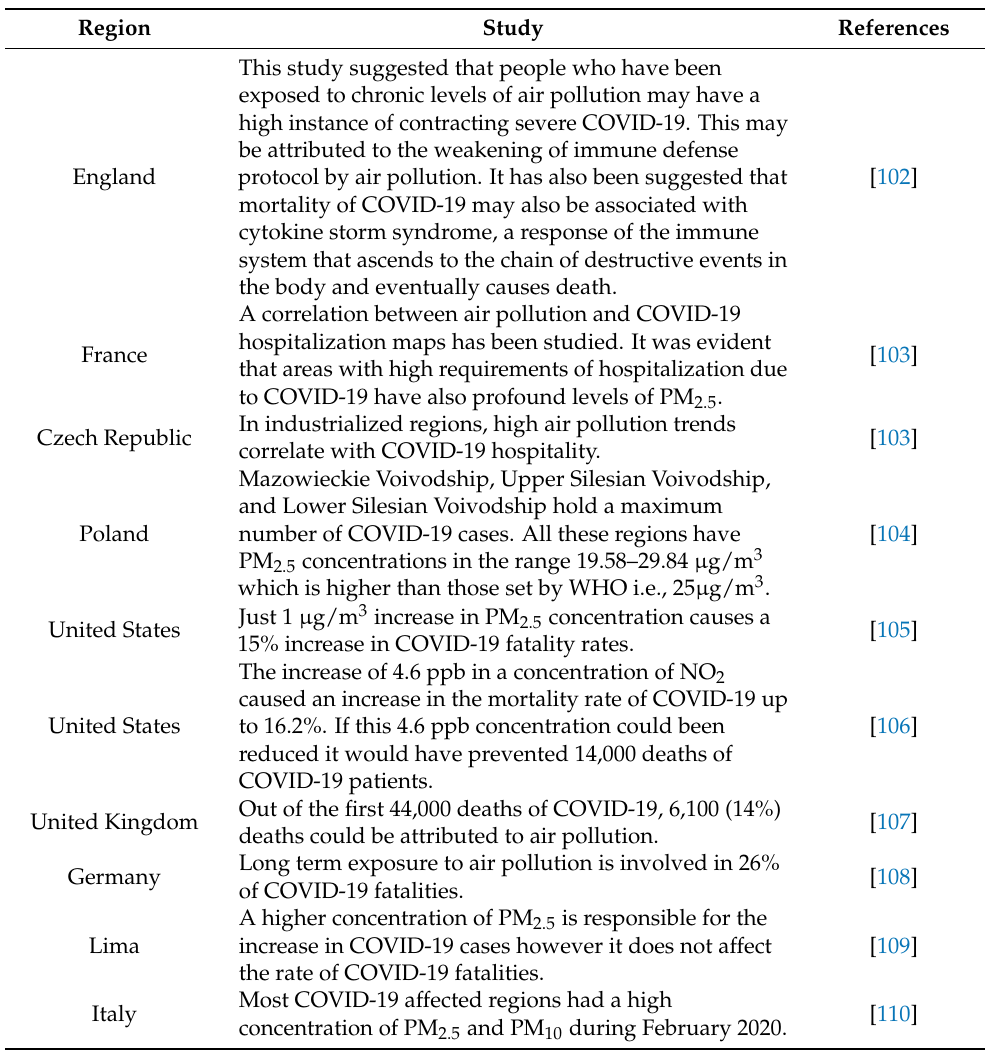
Table 9. Studies correlating high COVID-19 incidences to the high rates of air pollution. Region